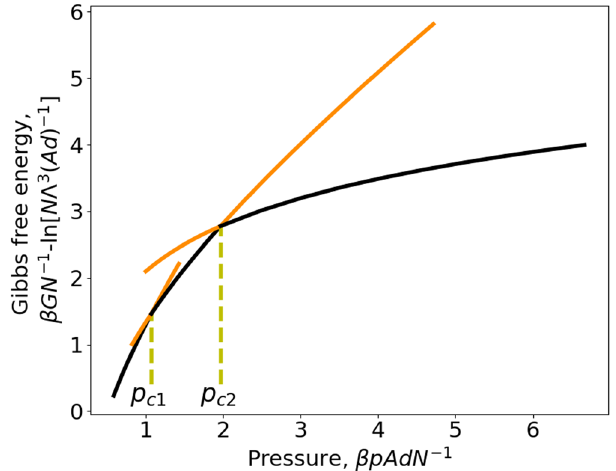
Fig. 2 | Gibbs free energy as a function of pressure of an ideal gas con fi ned in a slitpore. Repulsivesquare-wellgas-wallpotential( ε <0)atareducedtemperature, T =0 : 9525 ∣ ε ∣ k B (cid:1) 1 ð e βε =0 : 35 Þ . The large-pore branch (the left one) and the intermediate-pore branch (the middle one) cross at p c 1 , the intermediate-pore branch and the small-pore branch (the right one) cross at p c 2 . The black parts represent thermodynamically stable states while the orange parts correspond to metastable